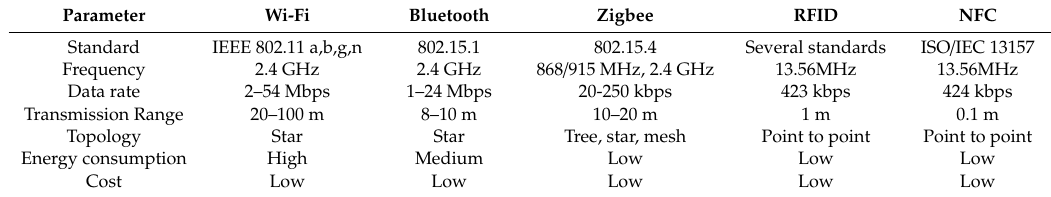
Table 1. Short range wireless networks communication technology